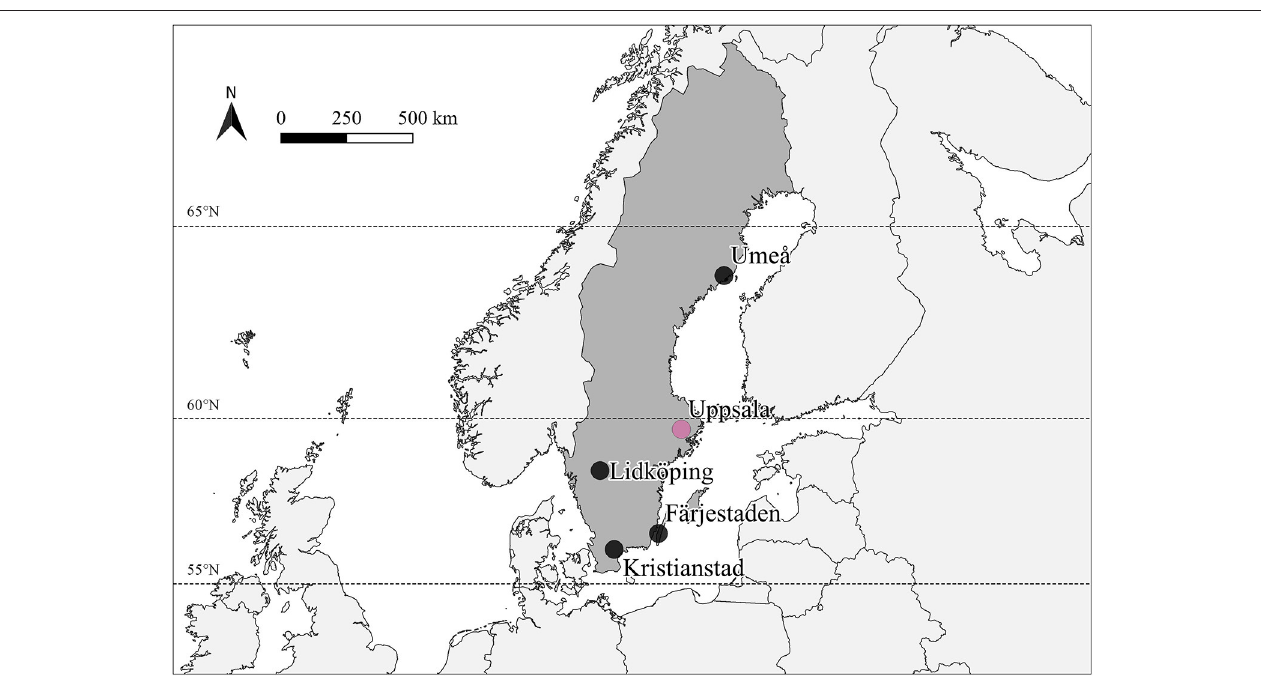
TABLE 1 | Sowing and harvest dates for each crop and location of the study. Crop Barley Maize Oats Spring wheat Location Färjestaden 05/05, 15/10 05/05, 15/10 05/05, 15/10 05/05, 15/10 Kristianstad 05/05, 15/10 05/05, 15/10 05/05, 15/10 05/05, 15/10 Lidköping 05/05, 15/10 05/05, 15/10 05/05, 15/10 05/05, 15/10 Umeå 25/05, 01/10 01/06*, 01/10* 25/05, 01/10 01/06*, 01/10* Uppsala 10/05, 15/10 10/05, 15/10 10/05, 15/10 10/05, 15/10 * indicates an estimated date for a location where the crop is not currently